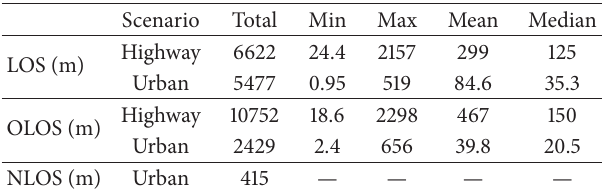
Table 1: Distance traveled in LOS, OLOS, and NLOS